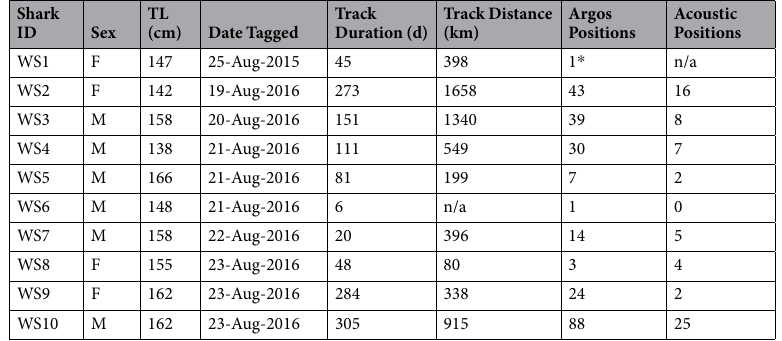
Table 1. Summary of information for white sharks tagged off Long Island, New York in 2015 and 2016. The Argos and acoustic positions represent counts of unique locations or receivers contributing to the final tracks (excluding interpolated positions). * PSAT pop-up location only.